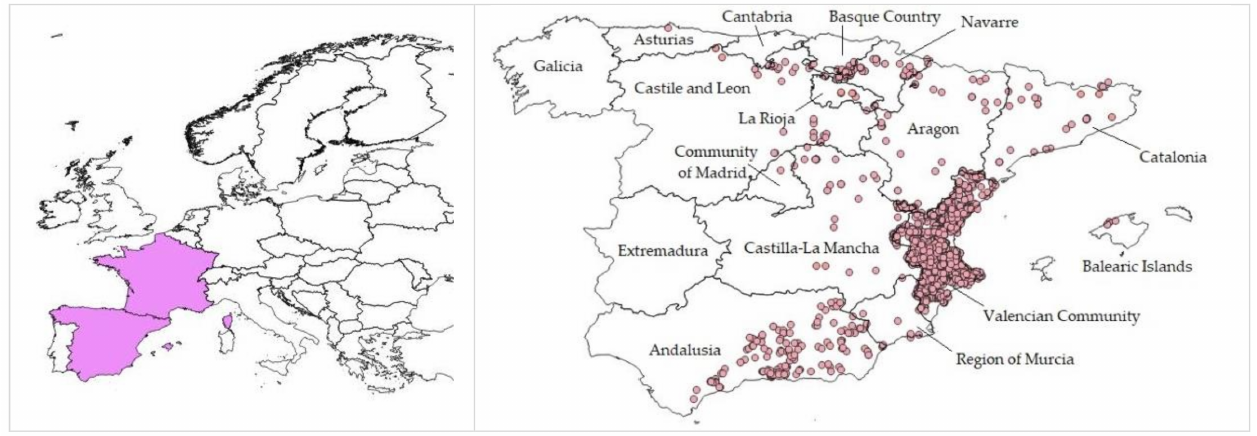
Figure 1. Distribution map of the species Chiliadenus glutinosus (L.) Fourr. (left) and detail in Spain produced in the ArcGis software from data obtained in GBIF [27,28], corrected according the last revision of the Flora Iberica